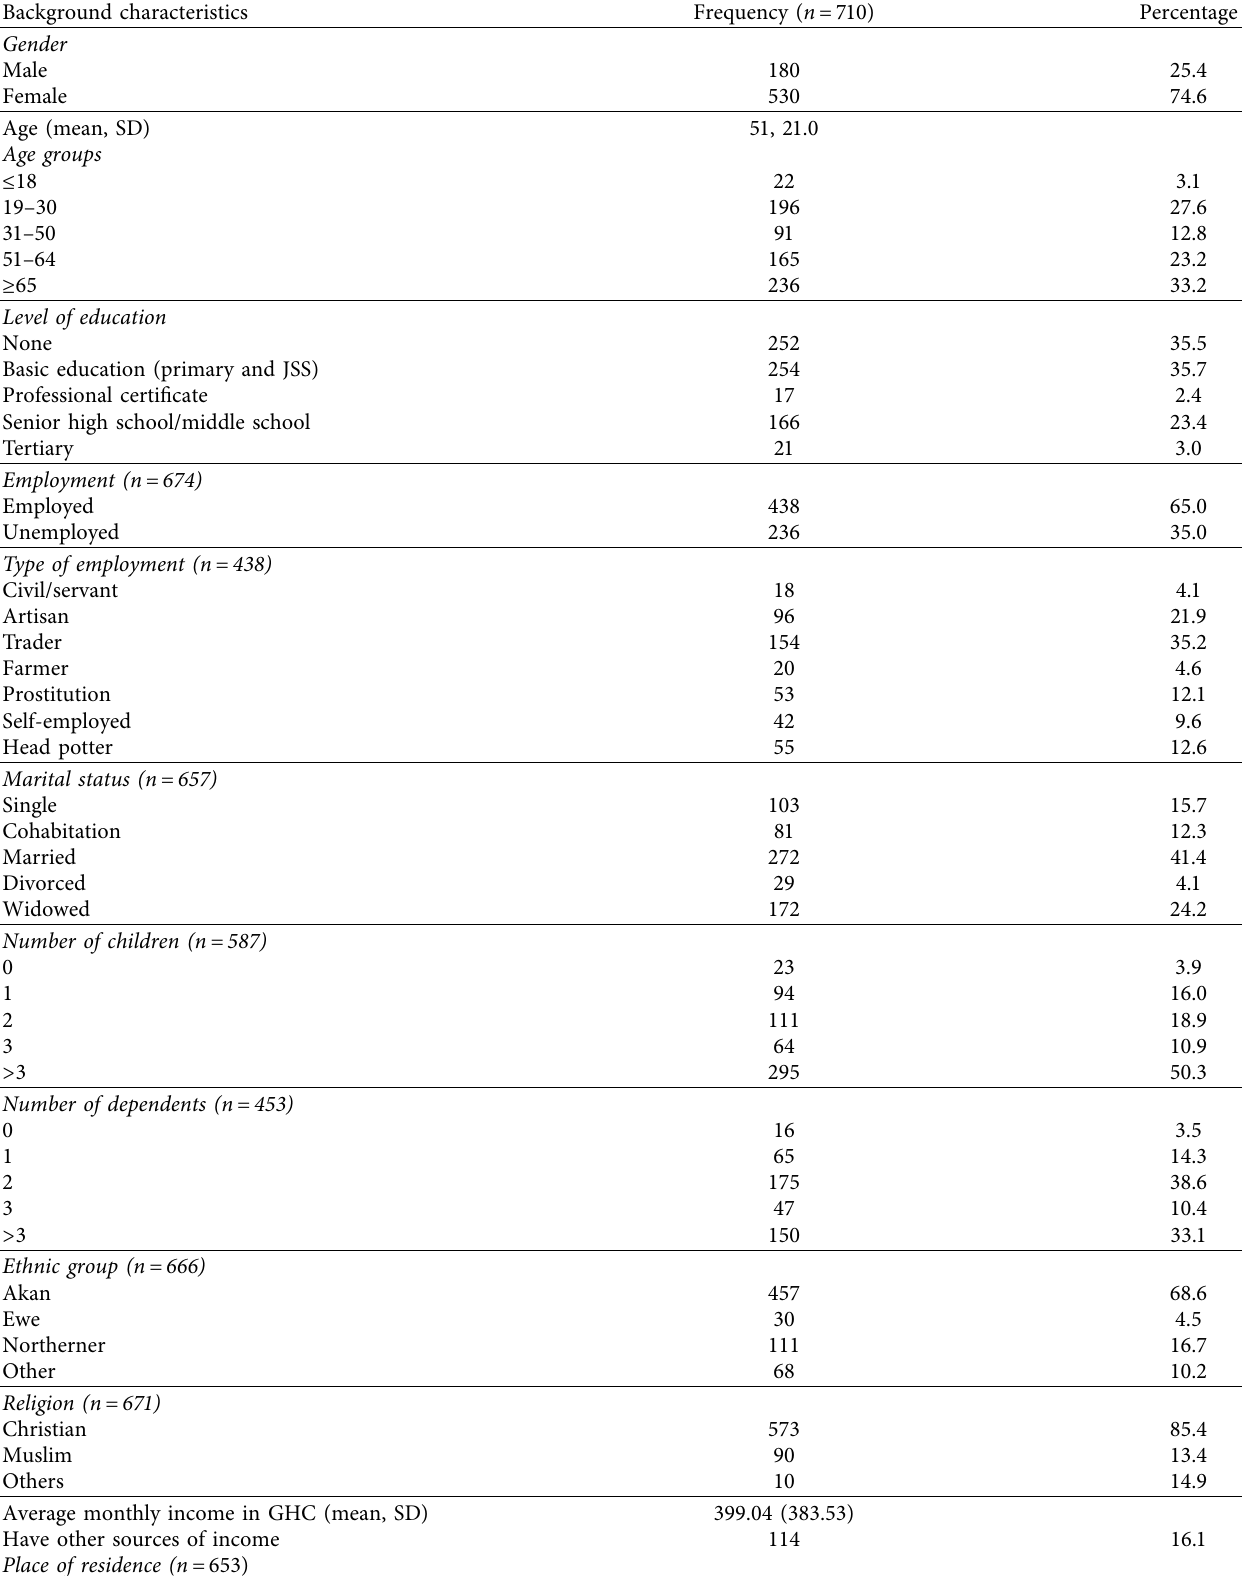
Table 1: Background characteristics of vulnerable